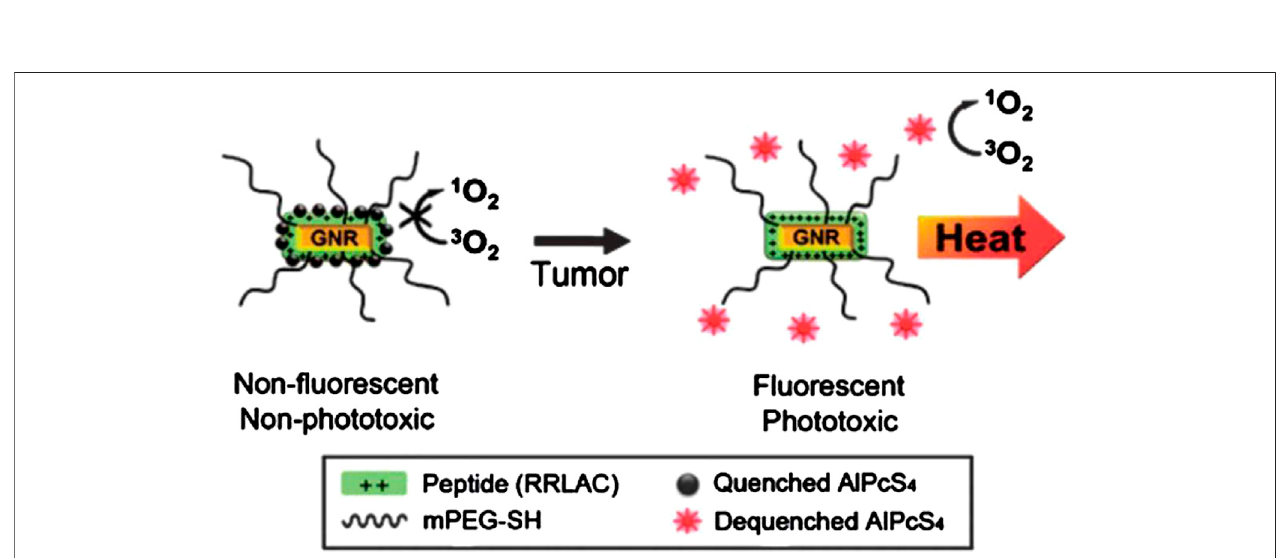
FIGURE5| AschematicdiagramofthegoldnanorodswhichconjugatedwithAlPcS4forsimultaneousNIRopticalimagingandphototherapy.Reprinted(adapted) with permission from Jang et al. (2011). ACS Nano. 2011,22,5 (2),1,086-94. Copyright 2011 American Chemical Society.